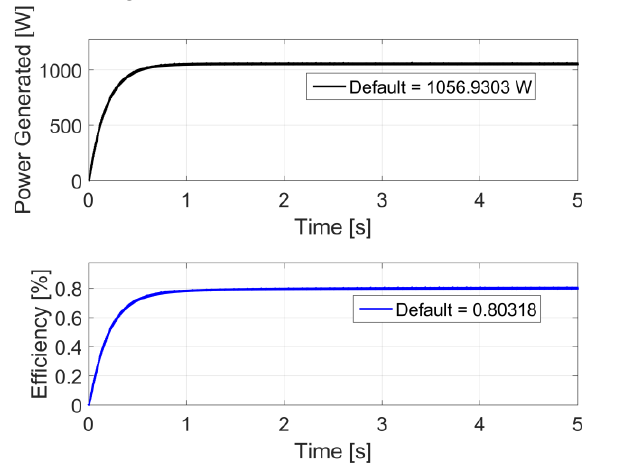
Fig. 5. SRG power and efficiency (open loop driving).